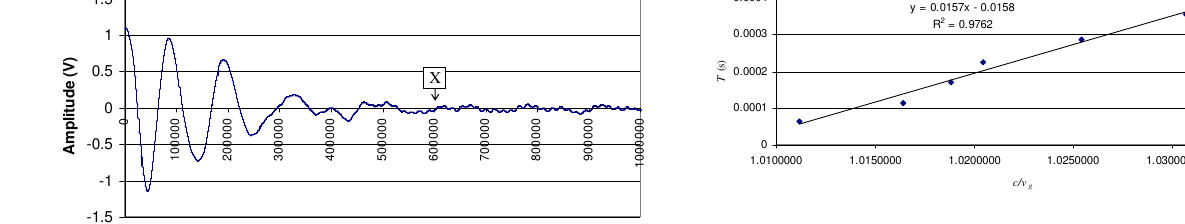
Fig. 5. Graph of quasi-wave period vs. c (cid:14) v g . Figure 5. Graph of quasi-wave period vs g vc . Table 1. Frequency and half-power band spread of the quasi- periodic